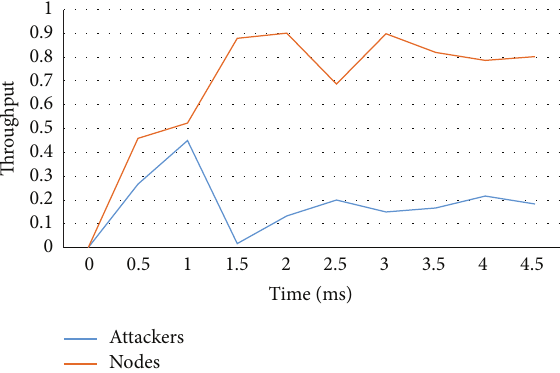
Figure 5: Throughput for 8 legitimate nodes versus 2 jammers.